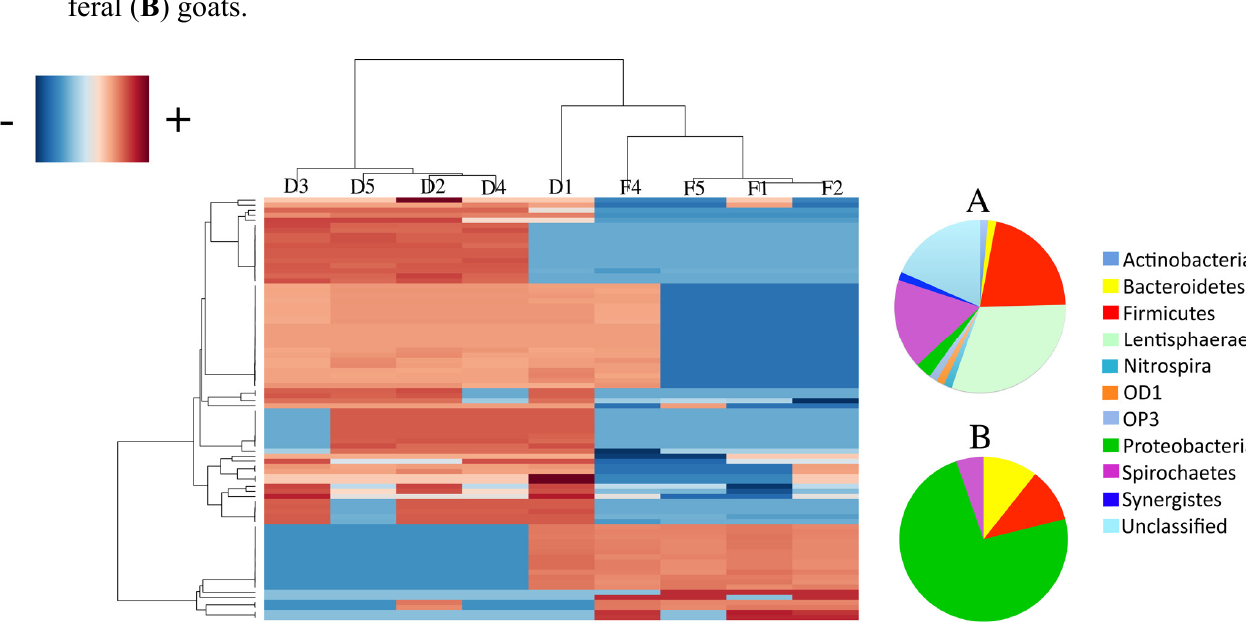
Figure 3. Hierarchical clustering and heatmap of the 84 OTUs that significantly differ between feral and domesticated goats. On the right, the pie charts depict phylum level distributions between bacterial taxa that were highly abundant in domestic ( A ) and in feral ( B )